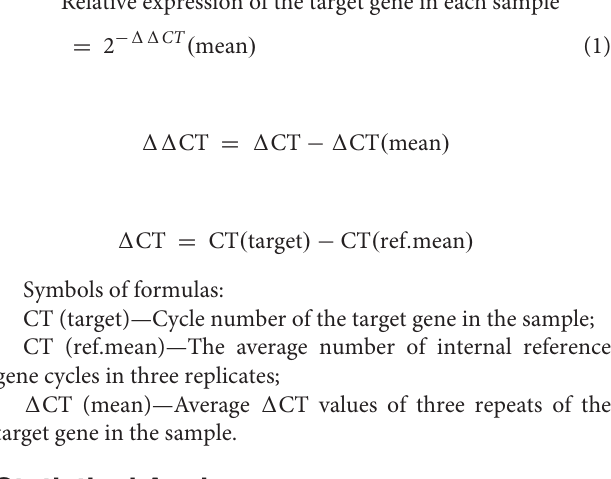
2 − (cid:49)(cid:49) CT mean values, which were positively correlated with the expression level, as shown in Formula